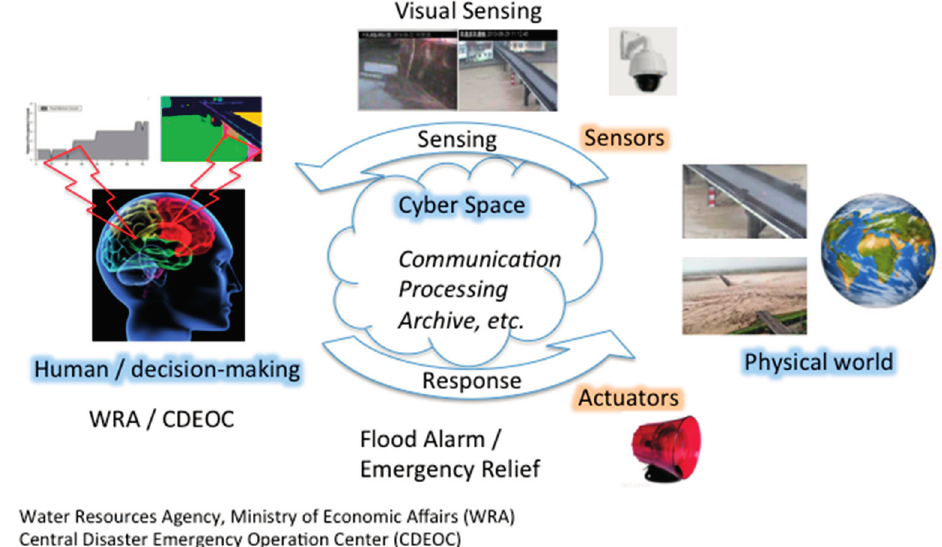
Figure 1. Flowchart of visual sensing for flood events. The system utilizes visual